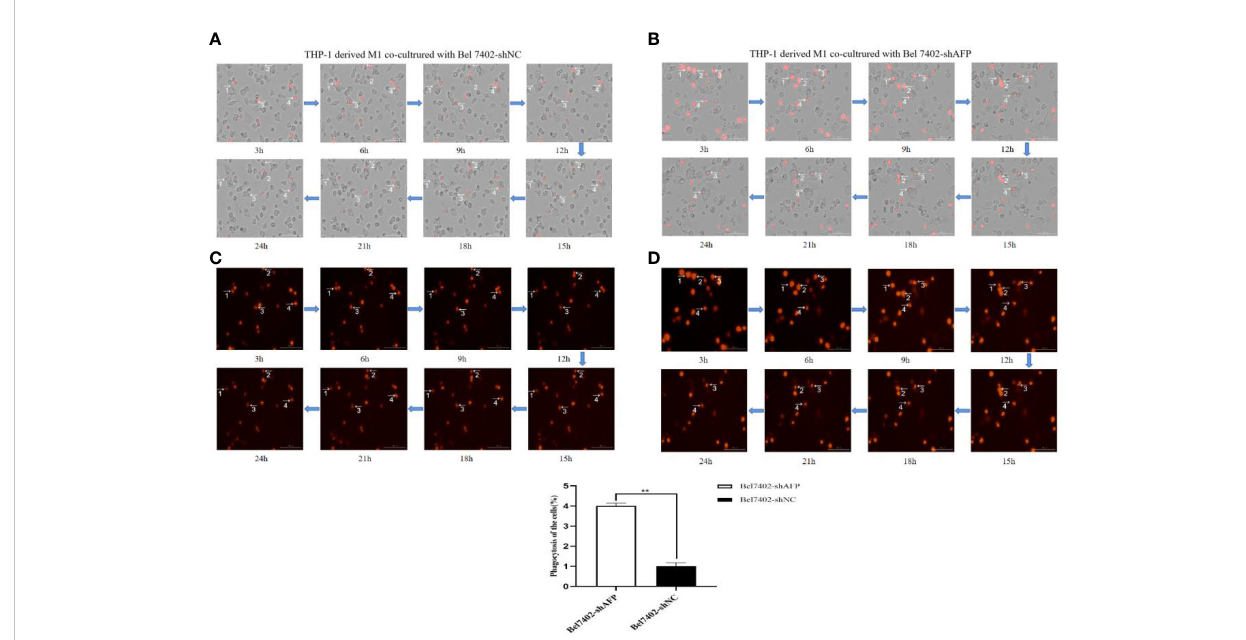
FIGURE 6 The effect of AFP on macrophages phagocytize HCC cells. M0 macrophages were administered LPS+IFN- g for 24 h to induce M0 macrophage polarization into the M1-like phenotype. (A) A bright fi eld channel was used to photograph the M1 macrophages co-cultured with Bel7402-shNC group. (B) A bright fi eld channel was used to photograph the M1 macrophages co-cultured with Bel7402-shAFP group; (C) Bel7402-shNC cells were photographed using the RFP channel; (D) , Bel7402-shAFP cells were photographed using the RFP channel. The macrophages phagocytized HCC cells was observed by an intelligent living-cell high-throughput imaging analyzer, and images were taken every 30 min for 24 h. The low column diagram shows statistical analysis of the numbers of phagocytic cells in 5 randomly selected fi elds, ** P <0.01. The images are from the at least three independent experiments. Red: Bel7402 cells; gray: THP-1 derived M1-type